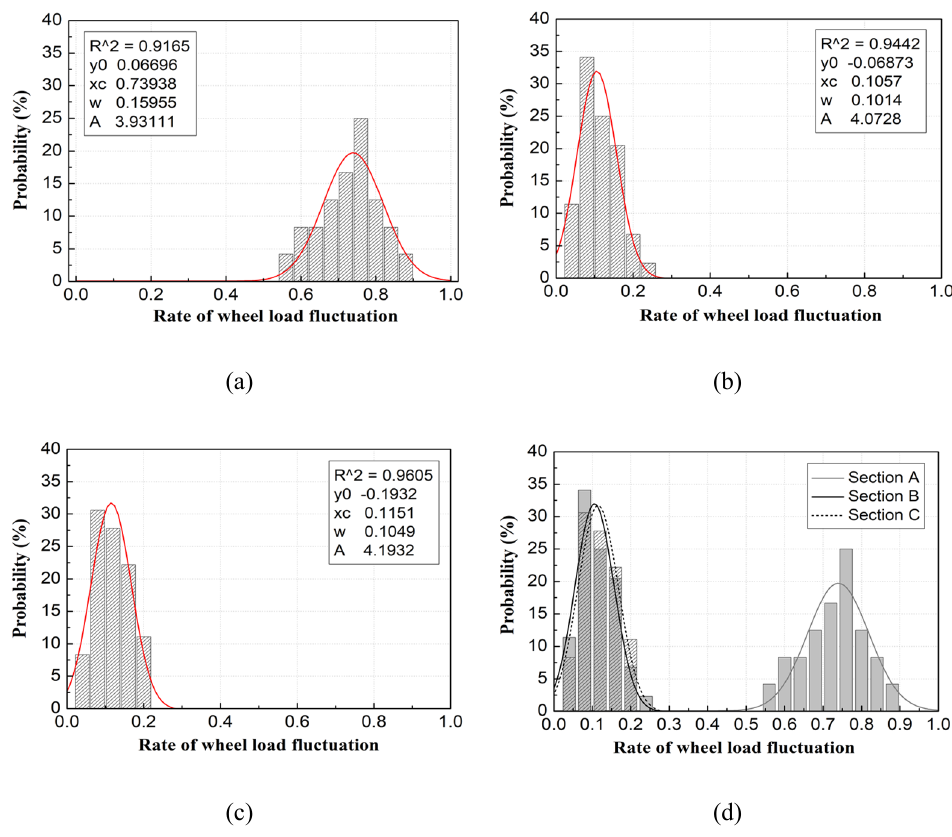
Figure 6. Gaussian analysis of wheel load fluctuations: ( a ) section A (track impact factor (TIF) = 1.899); ( b ) section B (TIF = 1.207); ( c ) section C (TIF = 1.220); and ( d ) results of Gaussian analysis for each section (R 2 : normal distribution, y0: y intercept, xc: mean, w: standard deviation, A: probability density).